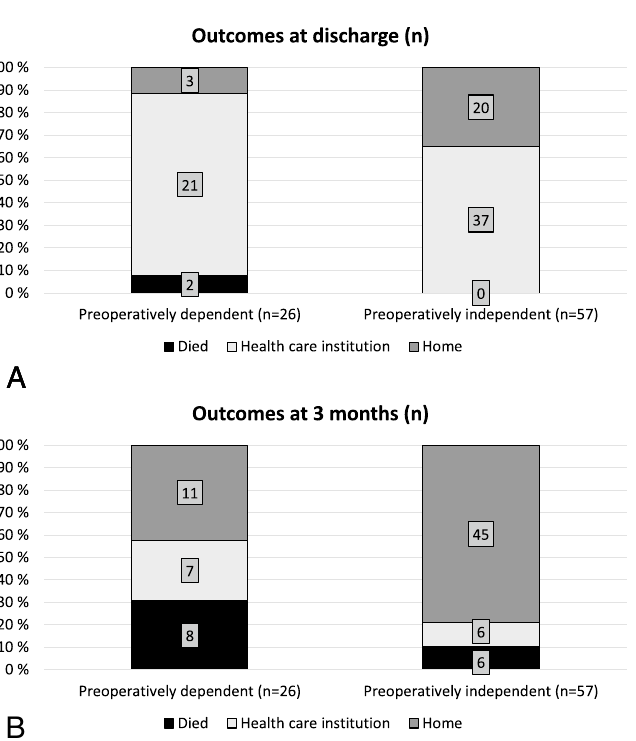
Figure 4. Postoperative capability to live at home (A) at discharge and ( B ) at 3 months. Preoperatively independent patients illustrate the patient who were able to live at home before surgery whereas preoperatively dependent patients illustrate patients who had lost their capability to live at home